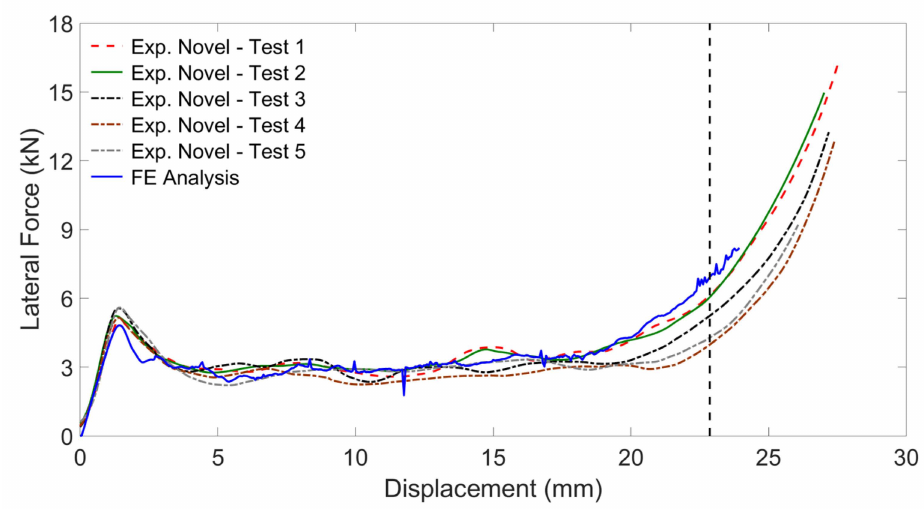
Figure 10. Reaction force versus displacement of the novel cell geometry with regular scale and under lateral loading: experimental and FE